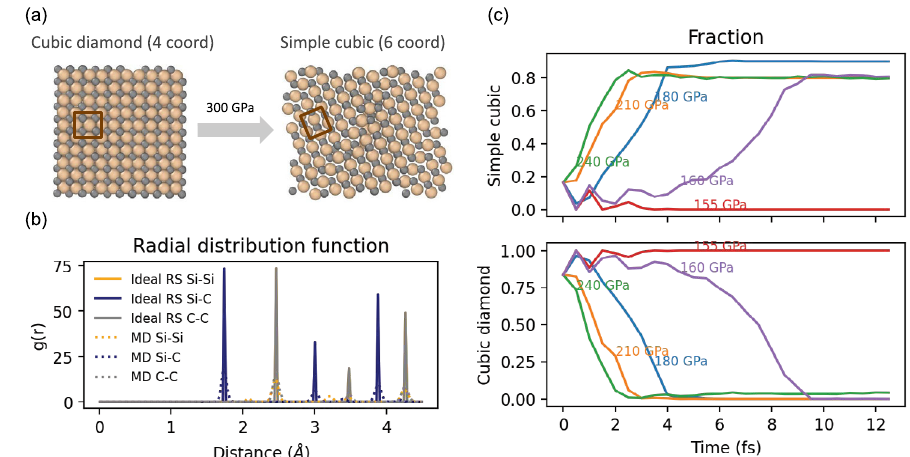
Fig. 3 Large-scale simulation of phase transition and analysis. a Large-scale MD with 1000 atoms for the 3C-RS phase transition after the training of FLARE BFF is fi nished. The transition is observed at 300 GPa at room temperature in MD. b The radial distribution function of the fi nal structure after transition in the MD, compared with the perfect RS crystal lattice, indicating the fi nal con fi guration is in the RS phase. c The fraction of simple cubic (RS) and cubic diamond (3C, zinc-blende) atomic environments from the phase boundary evolution at different pressures.